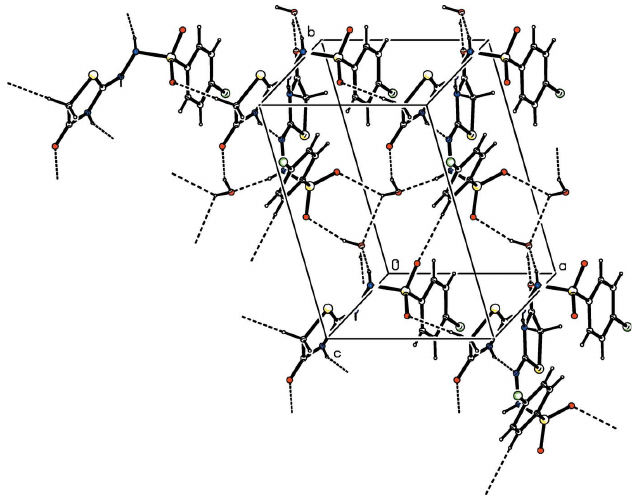
Figure 2 The molecular packing of the title compound, with hydrogen bonds (Table 1) shown as dashed lines.